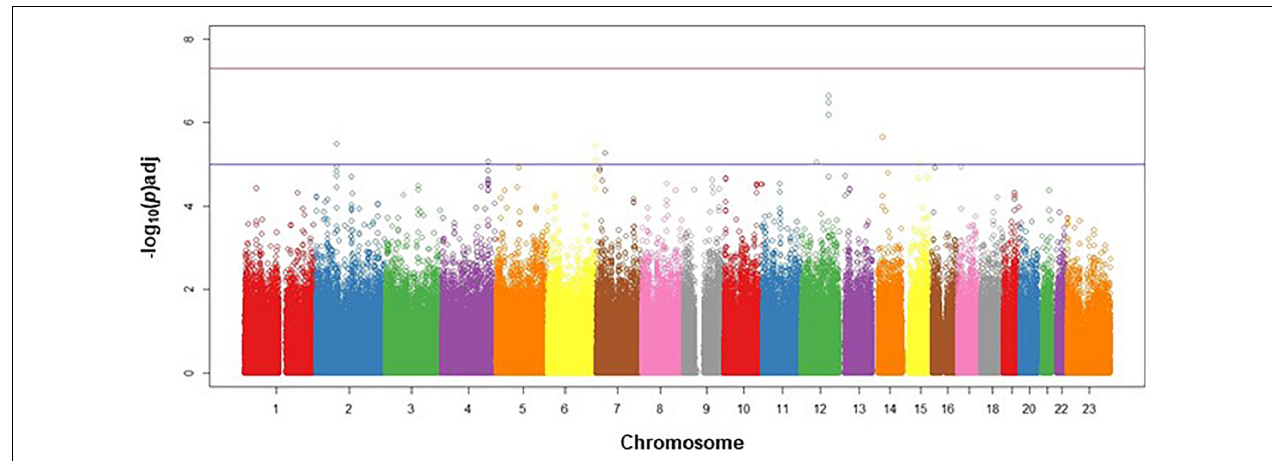
FIGURE 2 | Manhattan plot for discovery phase. Manhattan plot of discovery phase SNPs in genomic order by chromosome and position on the chromosome ( X -axis), plotted against the negative log (adj)p -value of each SNP’s association with survival events in CAD cases, adjusted for age, sex, and ancestry. Lower horizontal (blue line) represents p = 10 − 5 ; upper horizontal (red) line represents p = 5 × 10 − 8 .